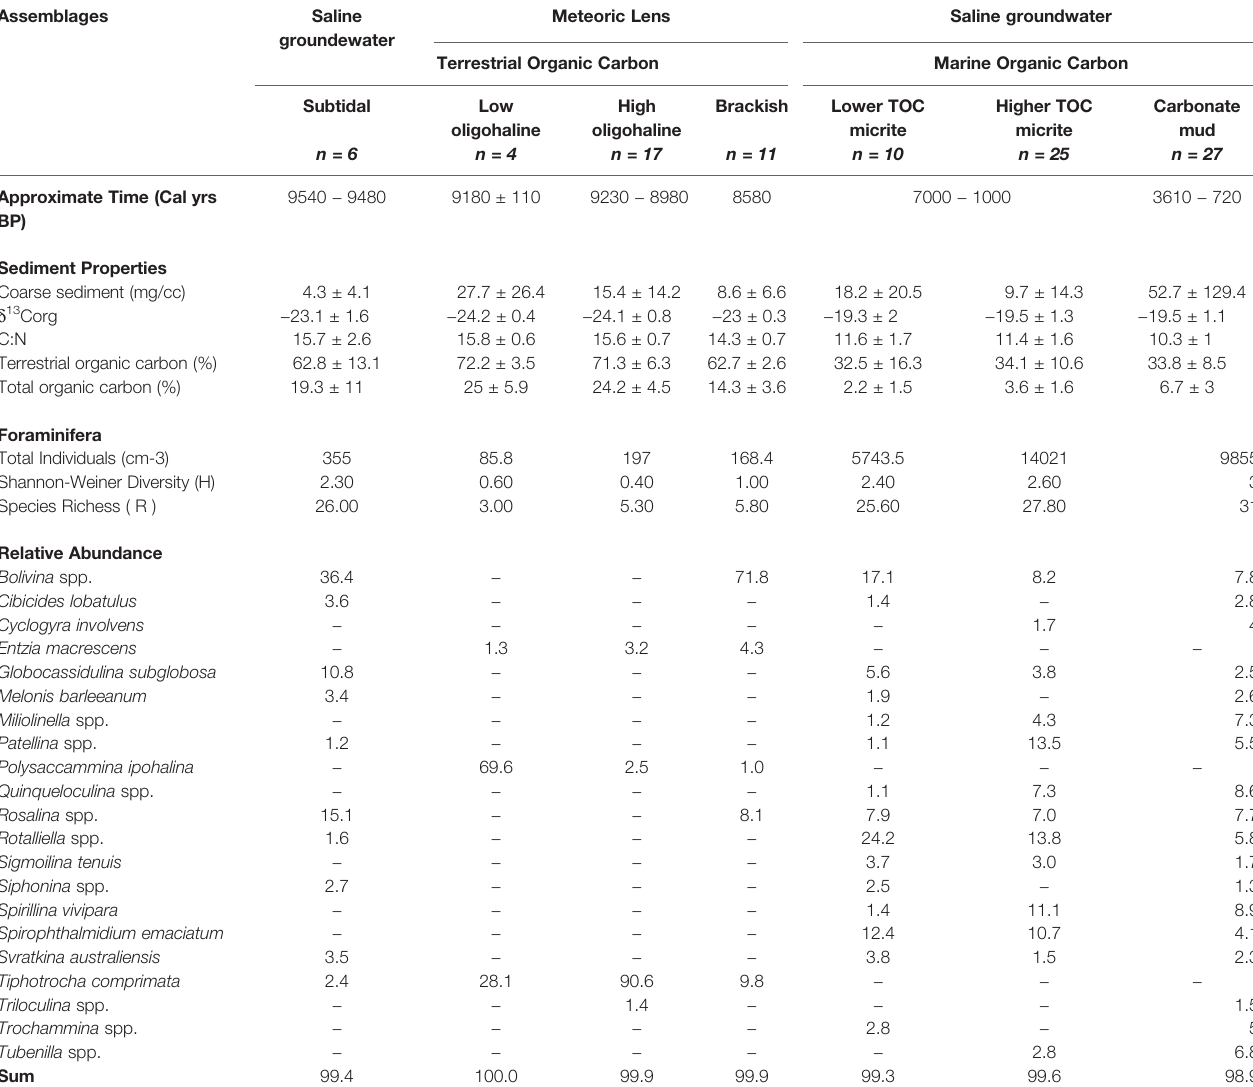
TABLE 1 | Diversity table for sediment cores. Arithmetic mean of the relative abundance of dominant taxa and textural characteristic for each assemblage. Species with a mean of <1% relative abundance in the assemblage were marked with a dash to emphasize dominant individuals.